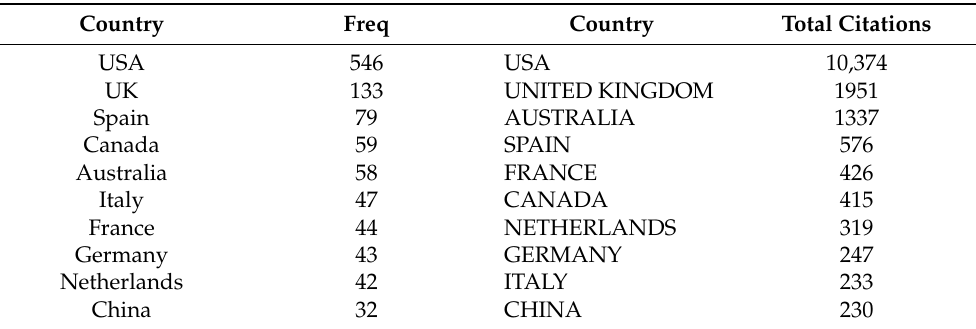
Table 7. Top 10 countries by publications and citations.